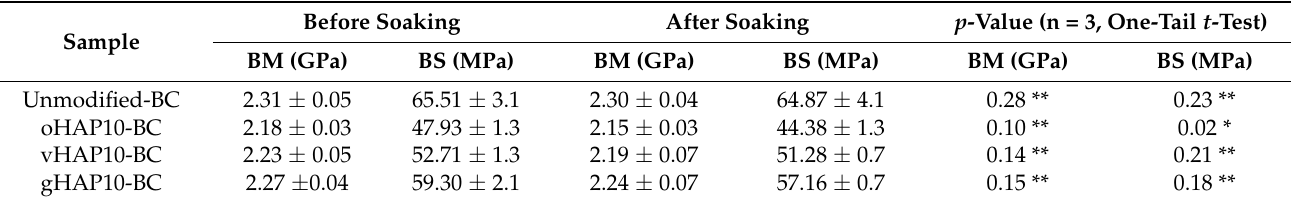
Table 3. Bending properties of unmodified and modified bone cements modified 10 wt.% of HAPs before and after soaking in saline for 72